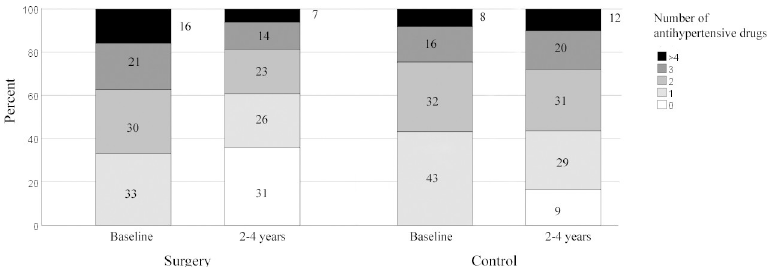
Fig 3. Stacked histogram of numbers of antihypertensive drugs before and 2–4 years after surgery. Stacked histogram for numbers of antihypertensive drugs before surgery and 2–4 years after surgery for hypertensive patients operated on with metabolic surgery compared with a matched control group from the general population with